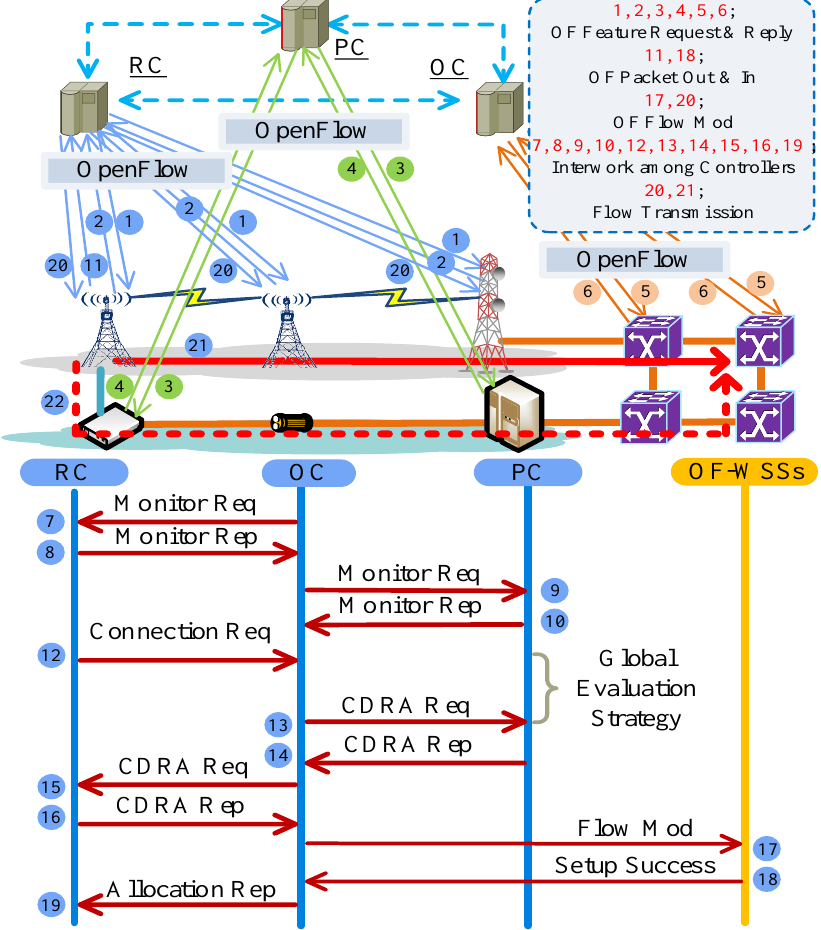
Figure 5. Interaction process for CDRA